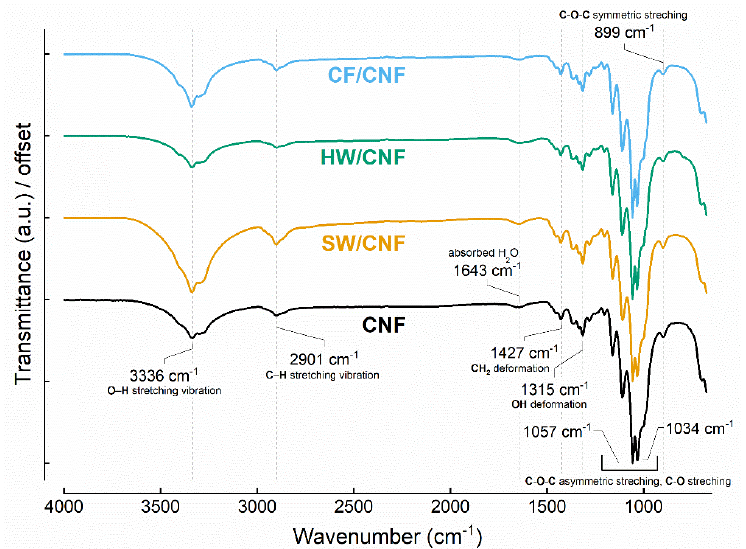
Figure 6. Attenuated total reflection–FTIR spectra of the lignocellulose membranes.